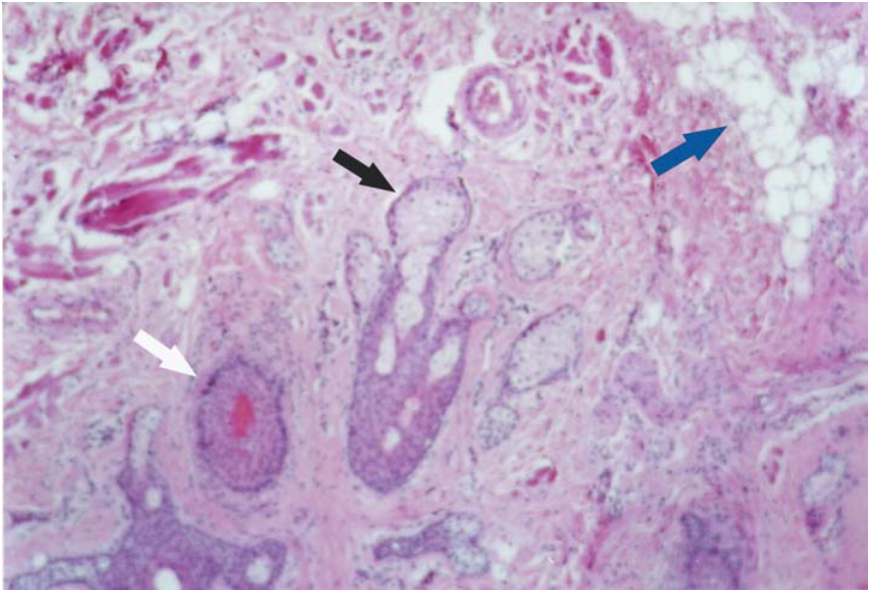
FIGURE 4 . Medium-power microscopy. Capsule cystic exhibiting a dense fibrous connective tissue with variables numbers of dermal appendages including hair follicles (white arrow), sebaceous glands (black arrow), and adipose tissue (blue arrow). (H&E, original magnification X